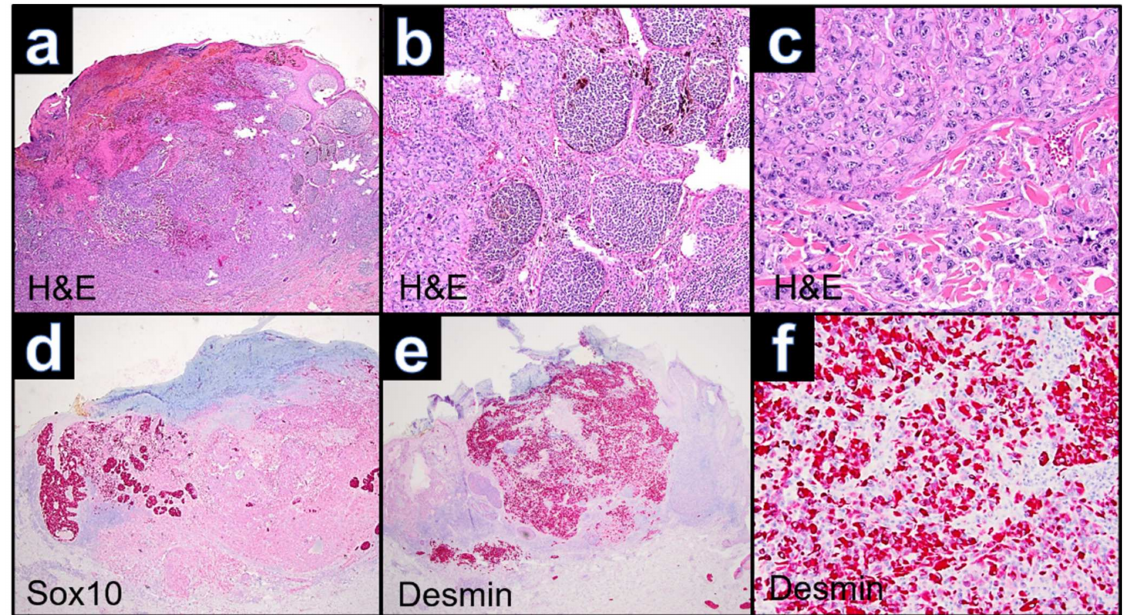
Figure 2. Case WUE1: ( a ): Panoramic view showing an ulcerated, relatively well-circumscribed elevated nodular lesion involving the dermis and subcutis (H&E, × 40). ( b ): Proliferation of nests or sheets of atypical polygonal neoplastic cells and nests with regular melanocytes (H&E, × 100). ( c ): Neoplastic cells with eccentrically located large round-to-oval nuclei containing conspicuous nucleoli and eosinophilic inclusions within the rich cytoplasm (H&E, × 400). ( d ): Negative staining for Sox10 of the rhabdoid differentiated melanoma cells and positivity of the regular melanocytic cells. ( e,f ): Expression of desmin by rhabdoid differentiated melanoma cells (Desmin × 40, × 100).